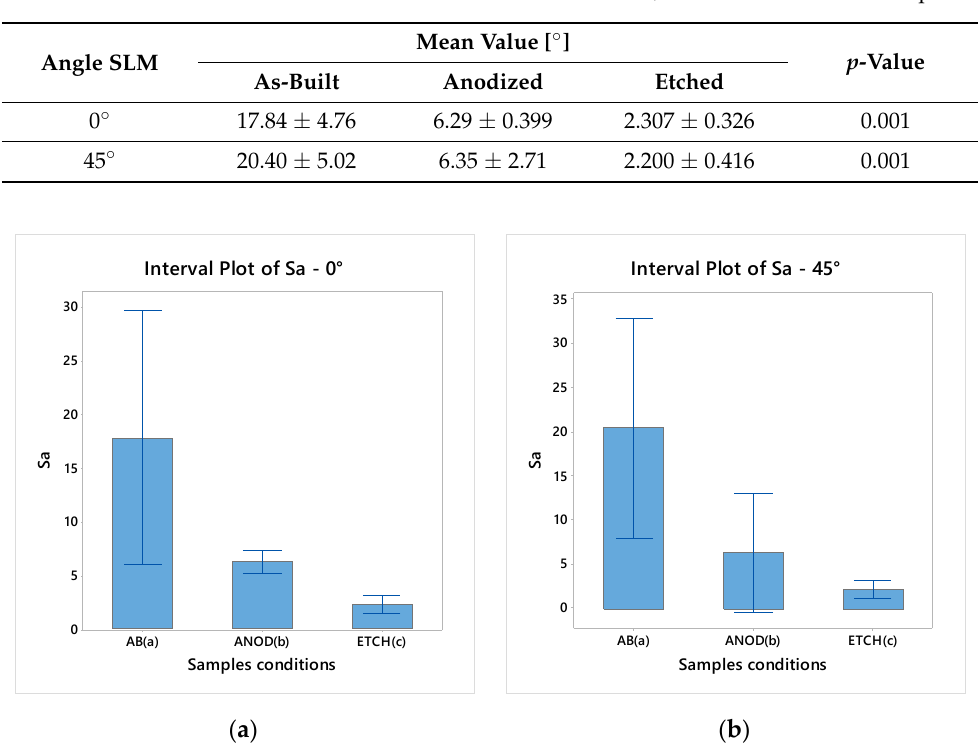
Figure 3. Sa measurements for the samples: ( a ) 0° building angle individual samples; ( b ) 0° building angle individual samples.